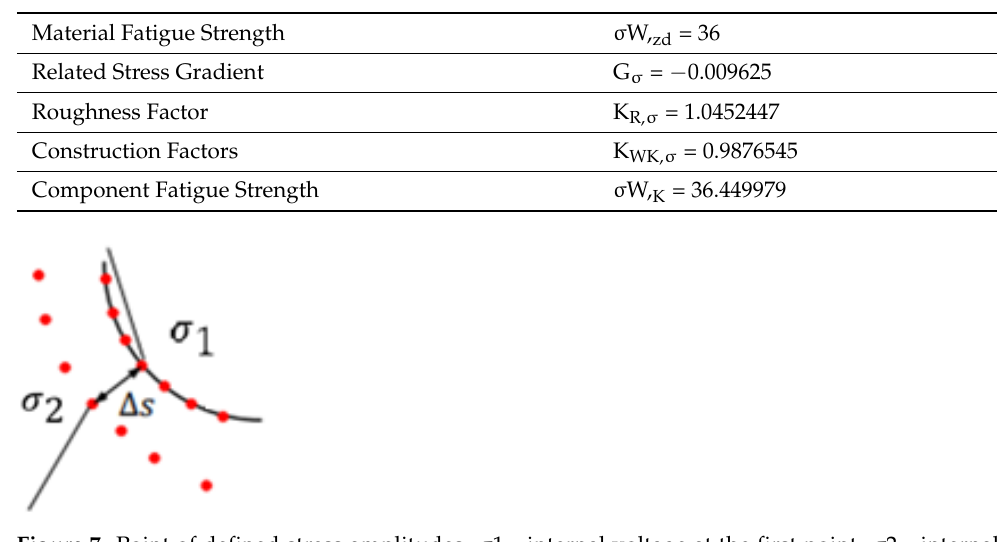
Figure 7. Point of defined stress amplitudes. σ1—internal voltage at the first point. σ2—internal voltage at the second point. ∆ s—the distance between the points.